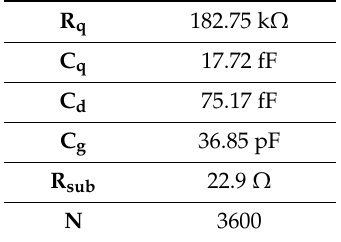
point, the lower the